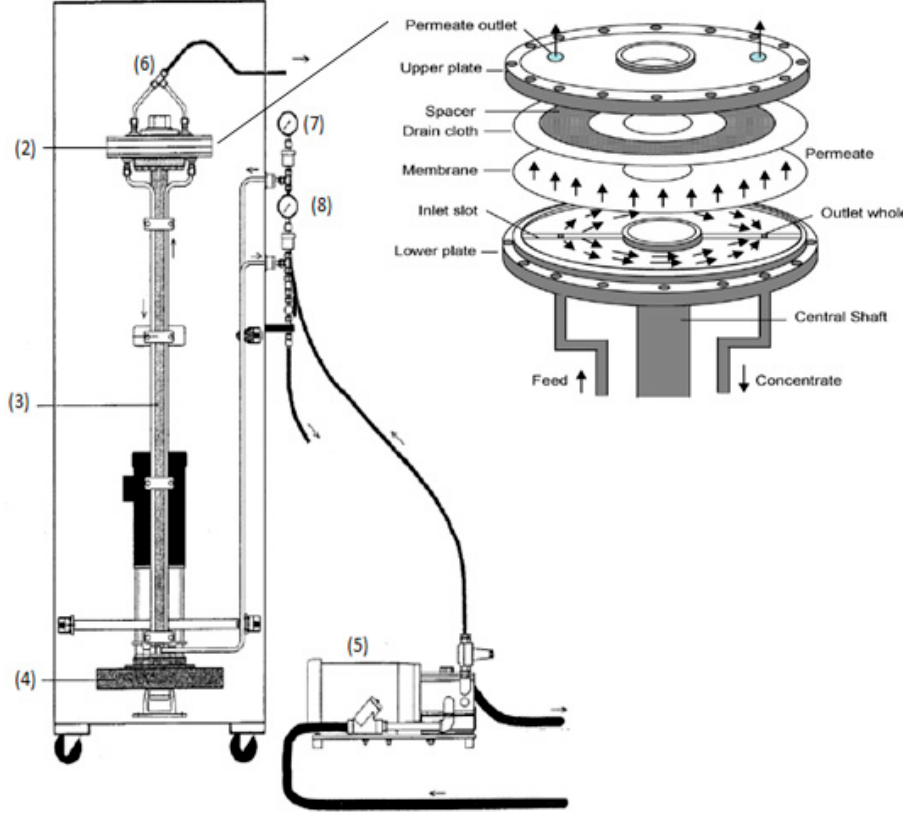
Figure 1. VSEP module: (1) circular housing, (2) annular membrane, (3) vertical shaft, (4) eccentric drive motor, (5) volumetric diaphragm pump, (6) top of the housing, (7) flow limiter, (8) control valve.